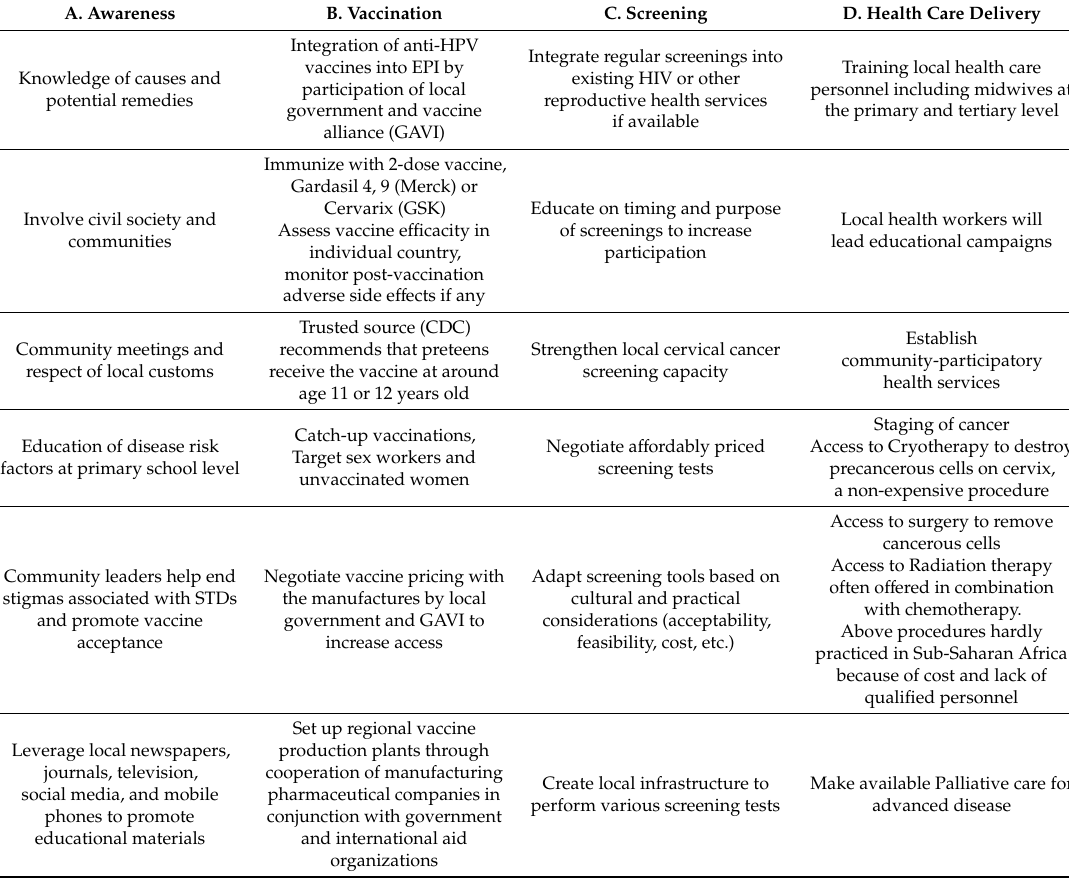
Table 2. Optimization of solutions to eliminate cervical cancer in Sub-Saharan